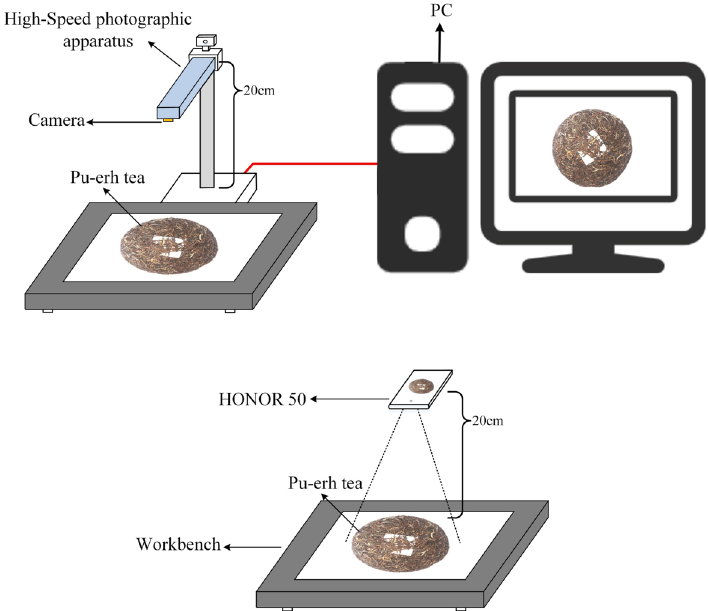
Figure 1. A schematic diagram of image